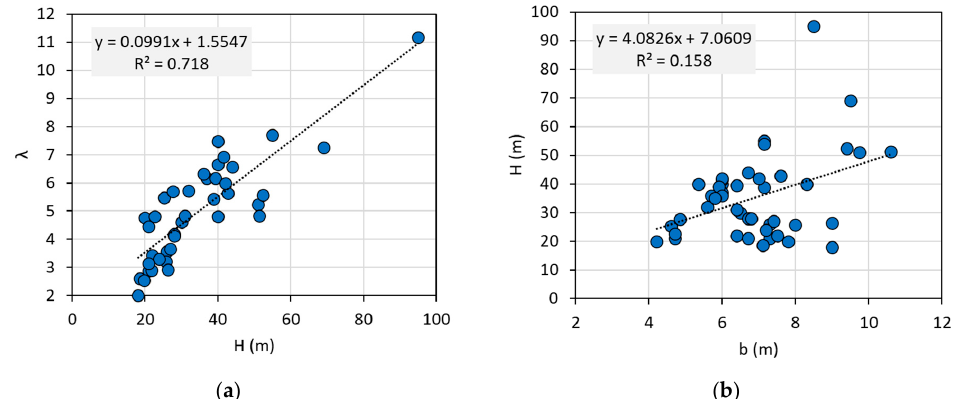
Figure 3. Correlation of geometrical properties (H—height; b—base width; λ —slenderness) from different masonry towers in the Italian territory from literature, ( a ) the correlation between the height of the structure and slenderness, ( b ) the correlation between the base width and the tower’s height.